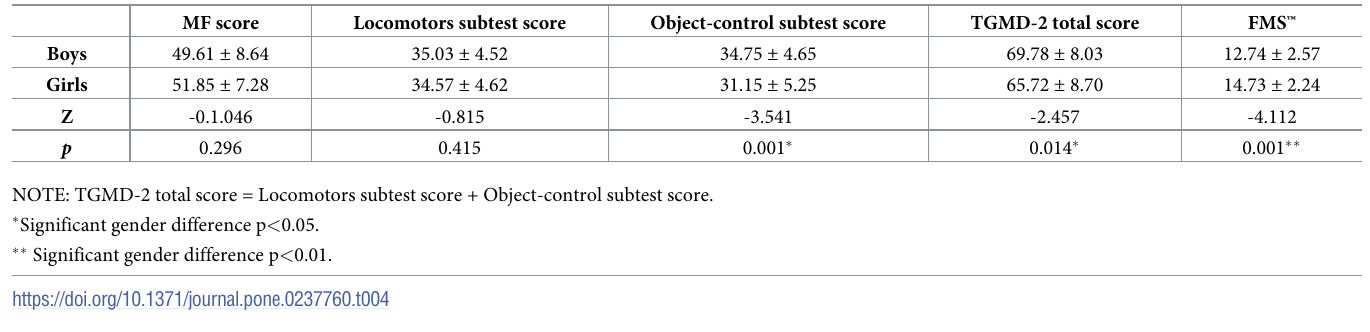
age-related differences among the TGMD-2 and FMS ™ scores. However, the MF test scores showed significant differences between age groups (grades; p = 0.008). The average TGMD-2 score at Grade 4 was 70.13 ± 9.68. Half of the 117 children scored less than or equal to 14 in the FMS ™ score, which is the cutoff value of injury prediction by restricted and asymmetrical fundamental movement patterns [48,49]. Table 3 presents the descriptive results of each grade group. Gender analysis. Boys scored significantly higher on the object-control subtest score (p < 0.001) and the TGMD-2 total score (p = 0.014) than girls. However, girls achieved a signif- icantly higher average score on the FMS ™ (p < 0.001) (Table 4). Girls scored significantly more points than the boys in the DS (p < 0.01), HS (p = 0.033), and ASLR (p < 0.001) parts of the